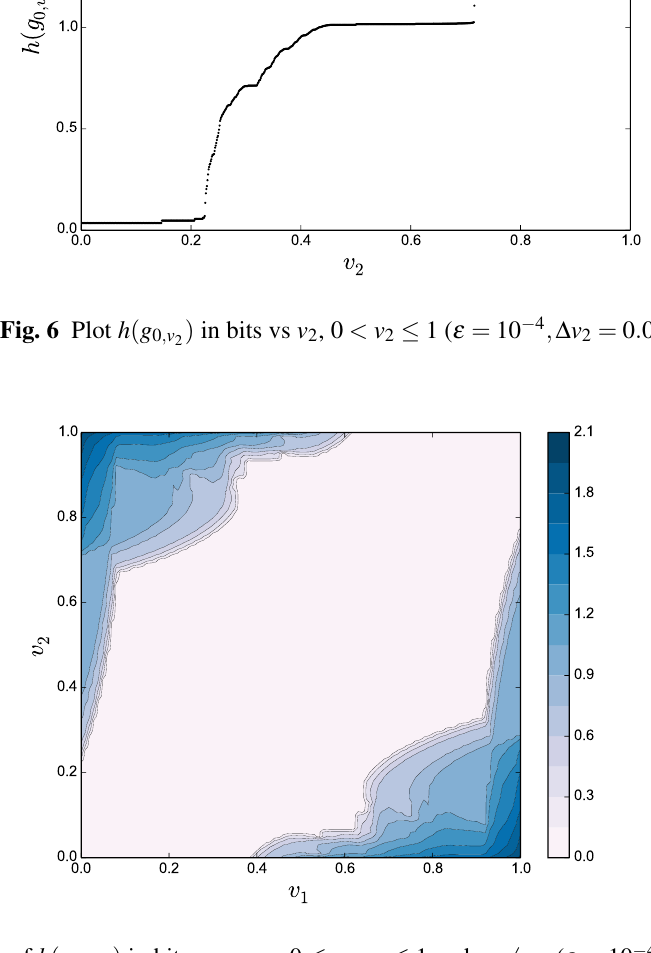
Fig. 7 Level sets of h ( g v ) in bits vs v 1 , v 2 , 0 ≤ v 1 , v 2 ≤ 1 and v 1 (cid:54) = v 2 ( ε = 10 − 4 , ∆ v 1 = ∆ v 2 = 0 . 01). 1 , v 2 expressions (19), (22), and also (11) add to other well-known ones for h ( f ) such as